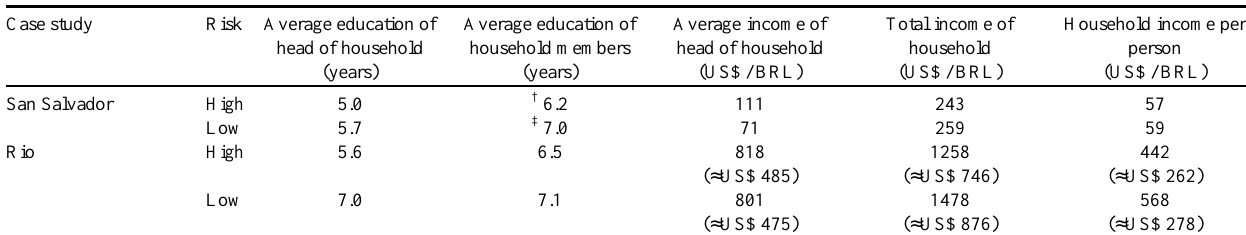
Table 1. Average education and income levels in focus and control groups (i.e., people living in high-risk and lower-risk areas) based on recent